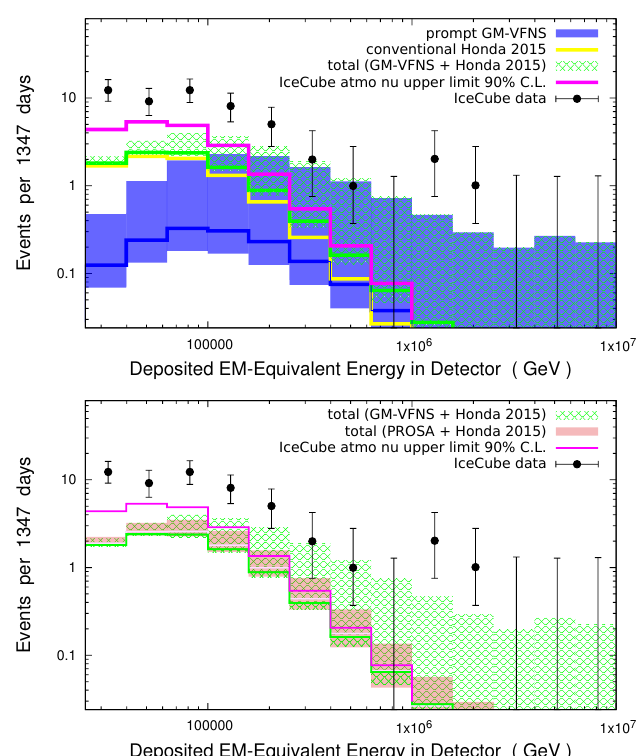
Figure 16 . Top: expected number of atmospheric-neutrino events after 4 years of data taking in comparison with IceCube experimental data [80], according to the HESE analysis setup. Theo- retical predictions (green) account for both the conventional component (yellow), according to the Honda 2015 model, reweighted for the H3a CR primary spectrum, and a prompt component (blue), computed according to the GM-VFNS method presented in this paper. Predictions for one or more astrophysical-neutrino components are not shown, whereas IceCube experimental data (black) also include neutrinos of non-atmospheric origin. The IceCube upper limit at 90% C.L. obtained in the analysis of ref. [81] and reproduced in ref. [80] is also shown (violet). The uncertainty in the total predicted number of events re(cid:13)ects the uncertainty in the prompt component, under the assump- tion that the conventional component does not lead to any additional uncertainty. See text for more details. Bottom: the total expected number of atmospheric neutrino events obtained in this work (green) for the 4-year HESE analysis con(cid:12)guration is compared with an updated version (from the 3-year to the 4-year case) of the one previously published in ref. [6], on the basis of a di(cid:11)erent computa- tion of the prompt component, making use of PROSA PDFs and POWHEGBOX + PYTHIA predictions for heavy-meson hadroproduction. IceCube HESE experimental data, including neutrinos of both atmospheric and other origins, are also shown. See text for more